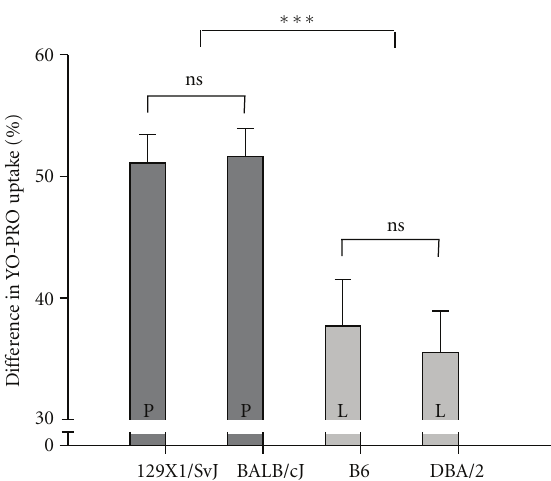
Figure 3: Dye uptake in the four major strains 129X1/SvJ, BALB/cJ, DBA/2, and B6, displayed as mean of di ff erences between the dye uptake in the control cultures and the dye uptake in the ATP, stimulated cell cultures ( ± SEM). P and L refer to P451 and 451L,